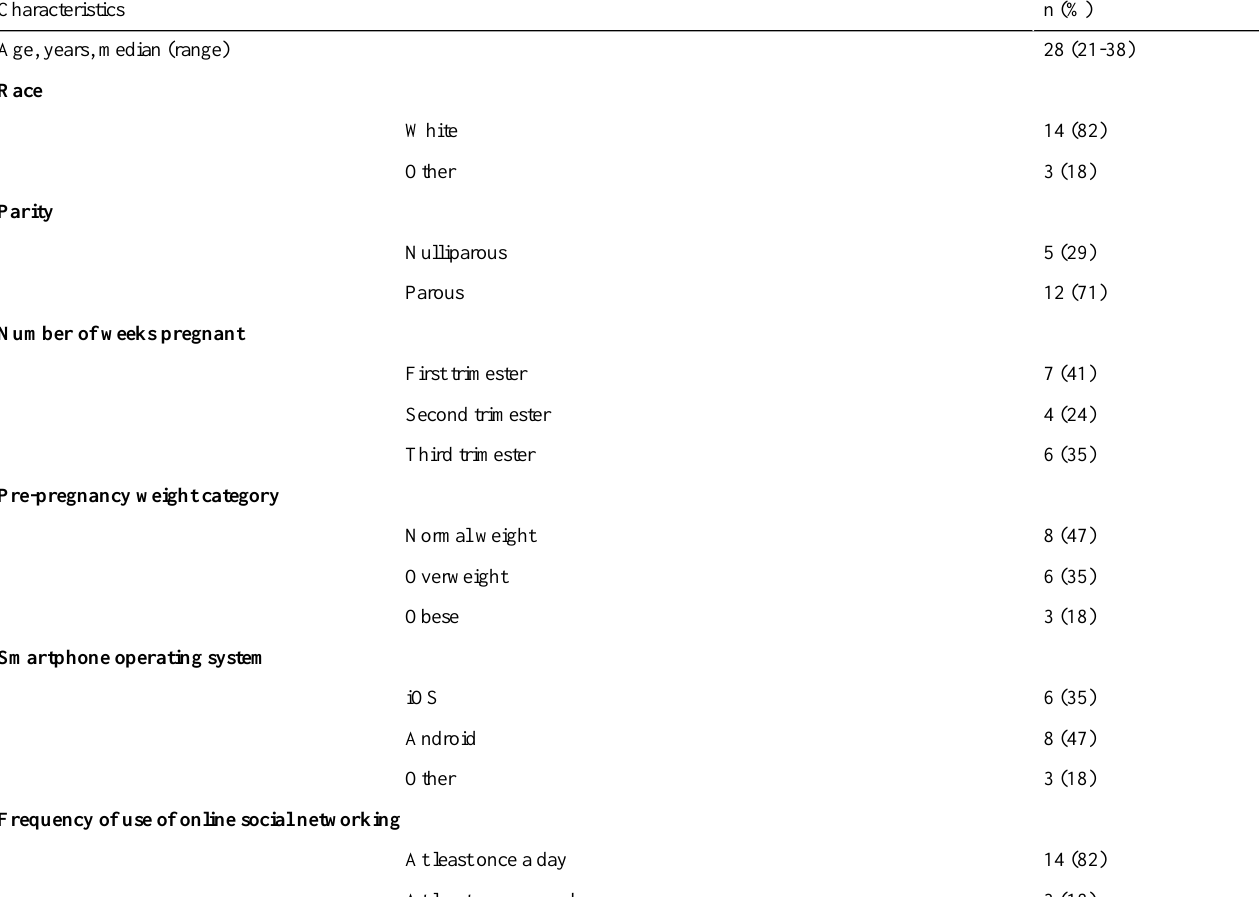
Table 1. Participant characteristics